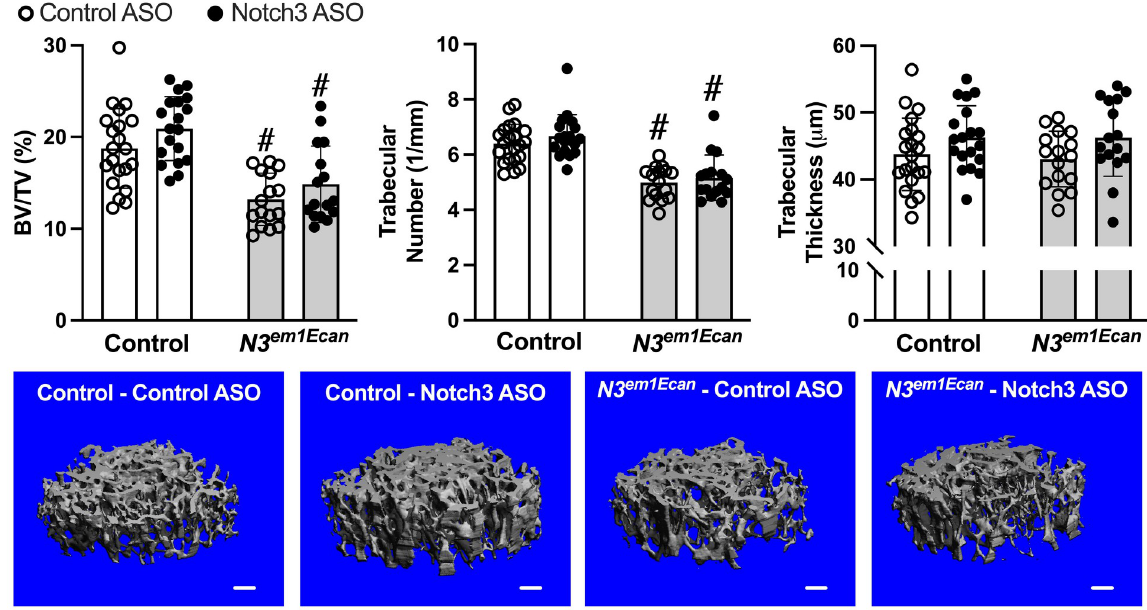
Fig 6. Cancellous bone microarchitecture assessed by μ CT of the distal femur from 8.5–9 week old Notch3 em1Ecan mutant (gray bars) male mice and sex-matched littermate controls (white bars) treated with Notch3 ASO (closed circles; n = 19 for mutant, n = 16 for Notch3 em1Ecan ) or control ASO (open circles; n = 21 for control, n = 16 for Notch3 em1Ecan ) both at 50 mg/kg subcutaneously, once a week for 4 weeks prior to sacrifice. Parameters shown are trabecular bone volume/total volume (BV/TV, %); trabecular number (1/mm) and thickness (um). Individual values are shown, and bars and ranges represent means ± SD of biological replicates. #Significantly different between Notch3 em1Ecan and control, p < 0.05. Representative images show cancellous bone osteopenia in Notch3 em1Ecan mutant mice and no effect by Notch3 ASO. Scale bars in the right corner represent 100 μ m.